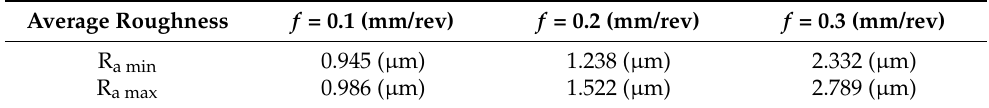
Table 5. Summary of measurements of average roughness for the whole range of values of cutting speed v c = {240, 270, 300} m/min, and depth of cut a p = {1, 1.7, 2.5} mm. Average Roughness f = 0.1